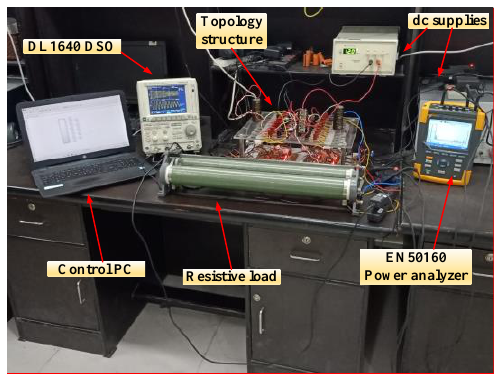
Table 7. Experimental parameters.